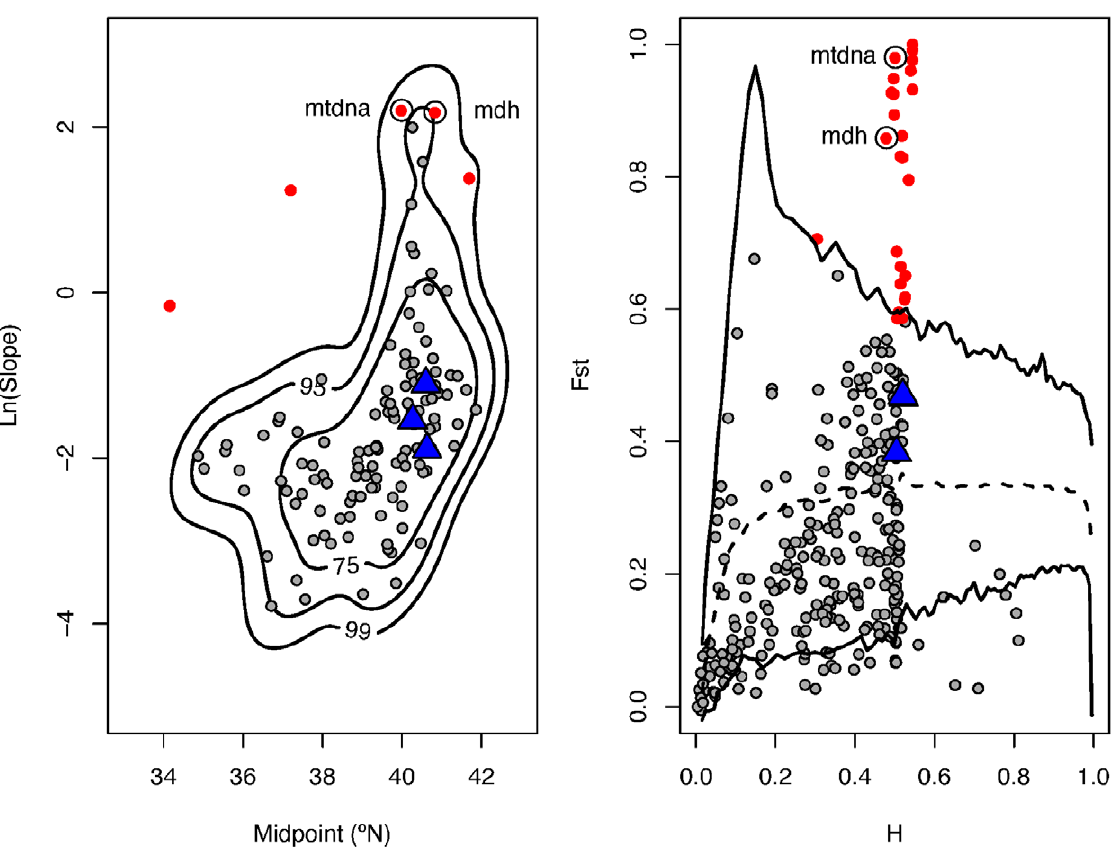
Figure 2. Identification of outlier loci based on Genomic Co-Co plot (left panel) and fdist2 (right panel) analyses. Contours of 75, 95 and 99% are shown on the co-co plot. Mean F ST is dotted and 99% C.I. lines are in black on the fdist2 panel. Outlier loci are in red (95% C.I.), non- outlier loci are in grey, and Ldh allozyme and SNPs are blue.